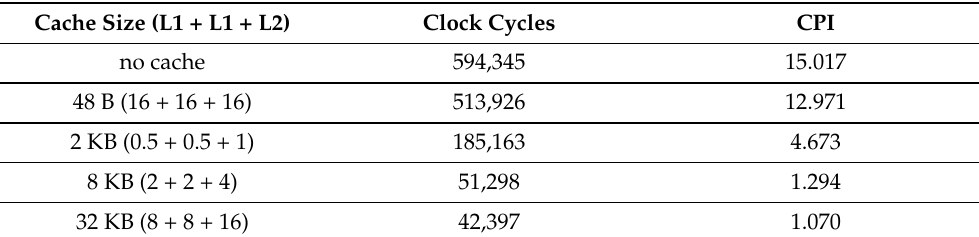
Table 2. FPGA emulation of Dhrystone SSRV (IOb-SoC) 32-bit at 50 MHz. 100 runs. 2-level cache system, sizes are for L1-Instr + L1-Data +